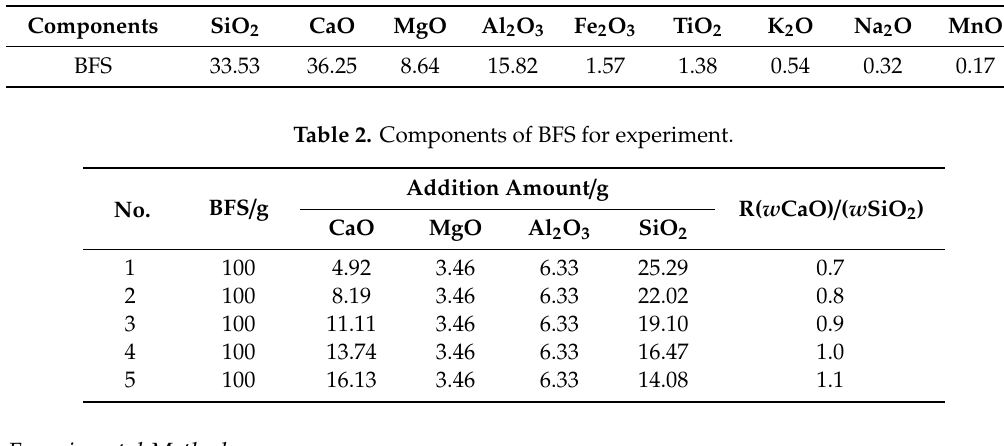
Table 1. The components of blast furnace slag (BFS) (wt%).